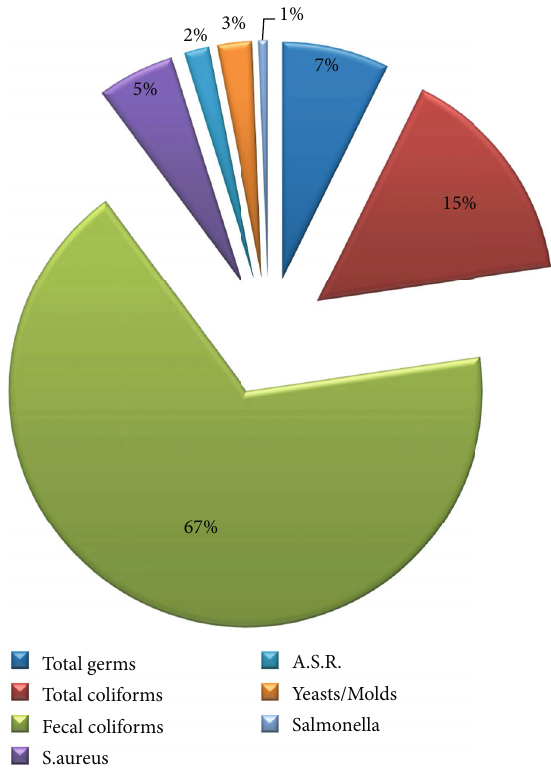
Figure 4: Non-conformity according to the